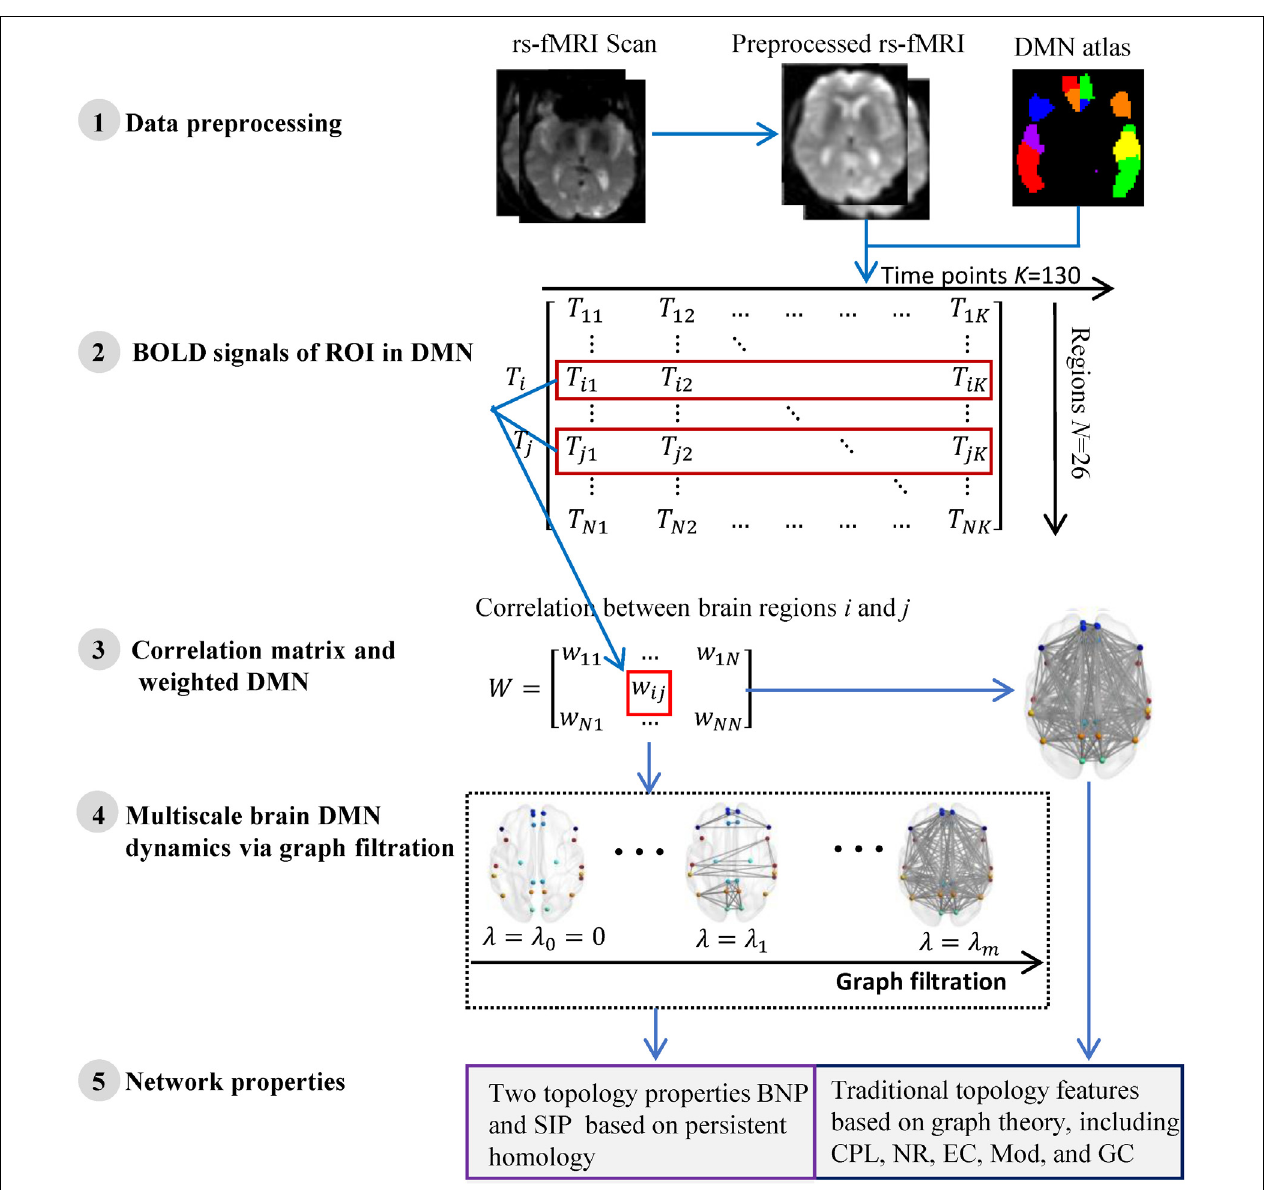
FIGURE 1 | The flow of measuring DMN topological structure based on graph theory and persistent homology in cognitively unimpaired subjects using rs-fMRI data from ADNI.